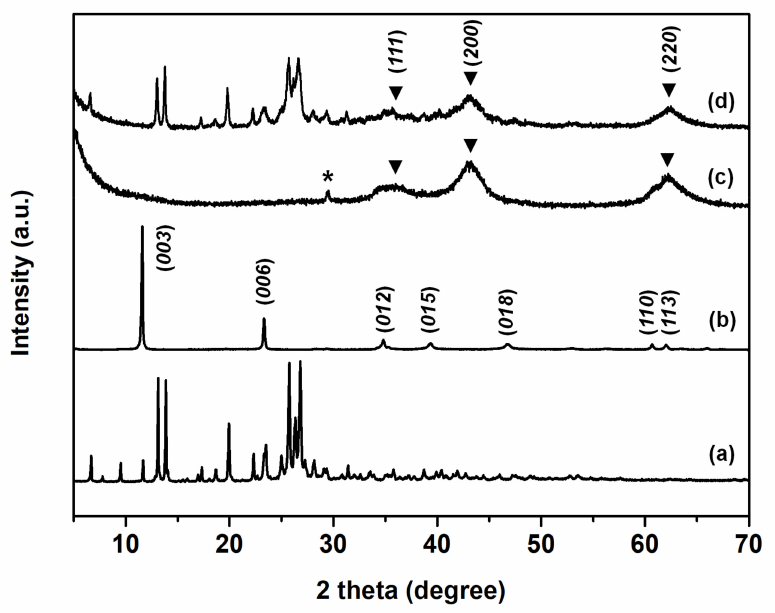
Figure 1. Powder X-ray diffraction patterns of ( a ) NIC, ( b ) HT, ( c ) DHT, and ( d ) NIC–DHT nanohy- brids. (*; impurity, (cid:72) ; periclase